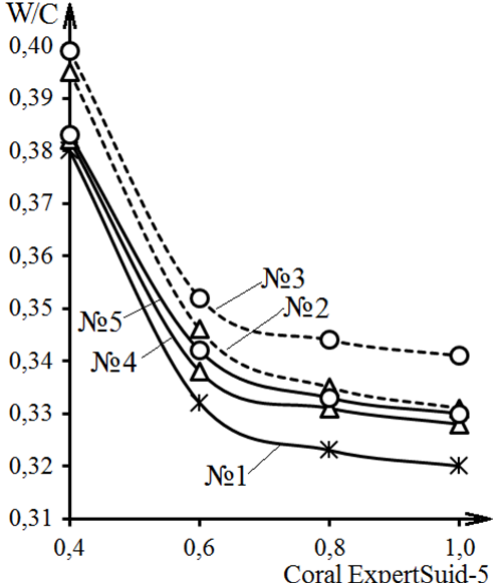
Figure 1. The influence of the amount of plasticizer and the type of sand on the W/C expanded clay lightweight concrete mixtures of equal